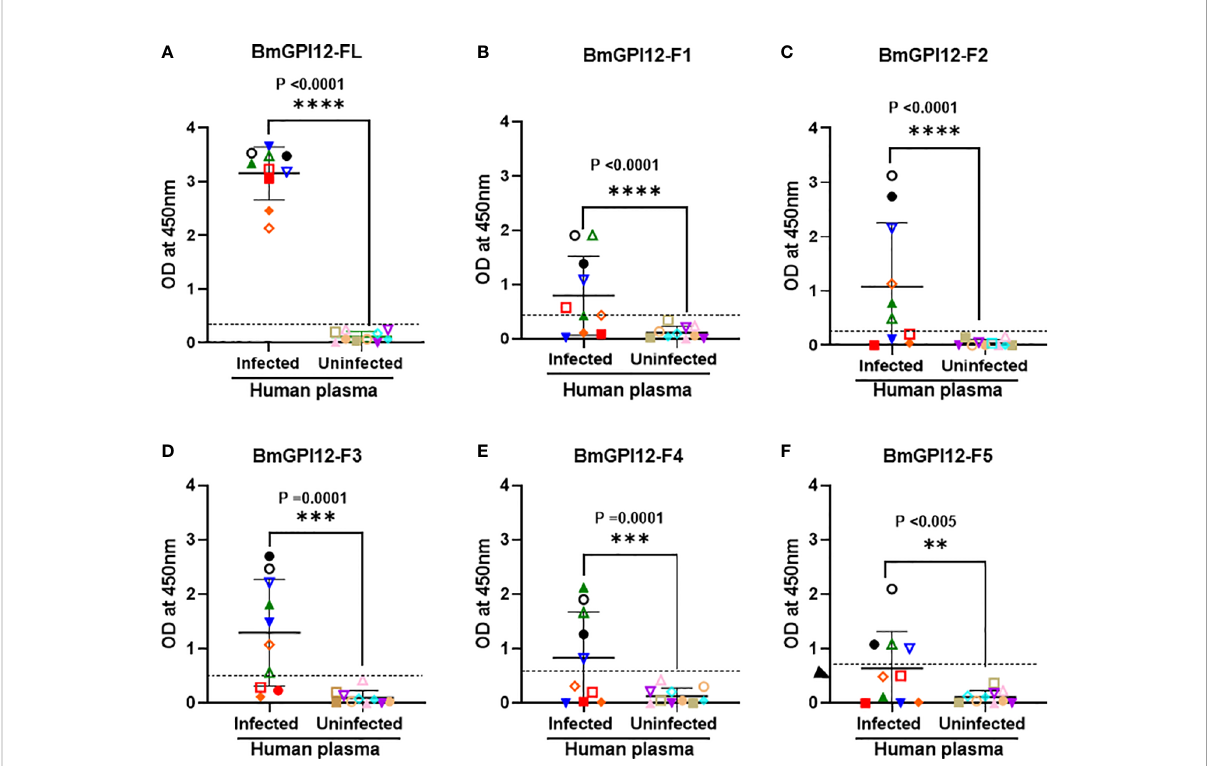
FIGURE 6 Detection of recombinant BmGPI12 or its sub-fragments using plasma from B microti PCR-positive and -negative humans. Graphs show the detection of full length BmGPI12 or its sub fragments (F1-F5) with B microti positive (by PCR or TMA) or negative (by TMA) human plasma samples. ELISA plates were coated with 50 ng/well of BmGPI12 FL (A) or fragments F1 (B) , F2 (C) , F3 (D) , F4 (E) , F5 (F) . Human plasma samples were used at 1:250 dilution. Each assay was conducted more than once with at least two technical replicates per assay. Error bars denote the standard deviation(SD) calculated using the Graphpad Prism 9.3 software. In all graphs, each color/symbol represents the reactivity of individual human plasma sample to different BmGPI12 antigens. Statistical signi fi cance was calculated using two-way ANOVA. The OD 450 cut-off (dashed line) denotes the mean + 2 x SD of the OD 450 value of the negative samples. ****: statistically signi fi cant (p<0.0001, by two-way ANOVA); ***: statistically signi fi cant (p=0.0001, by two-way ANOVA); **: statistically signi fi cant (p<0.005, by two-way